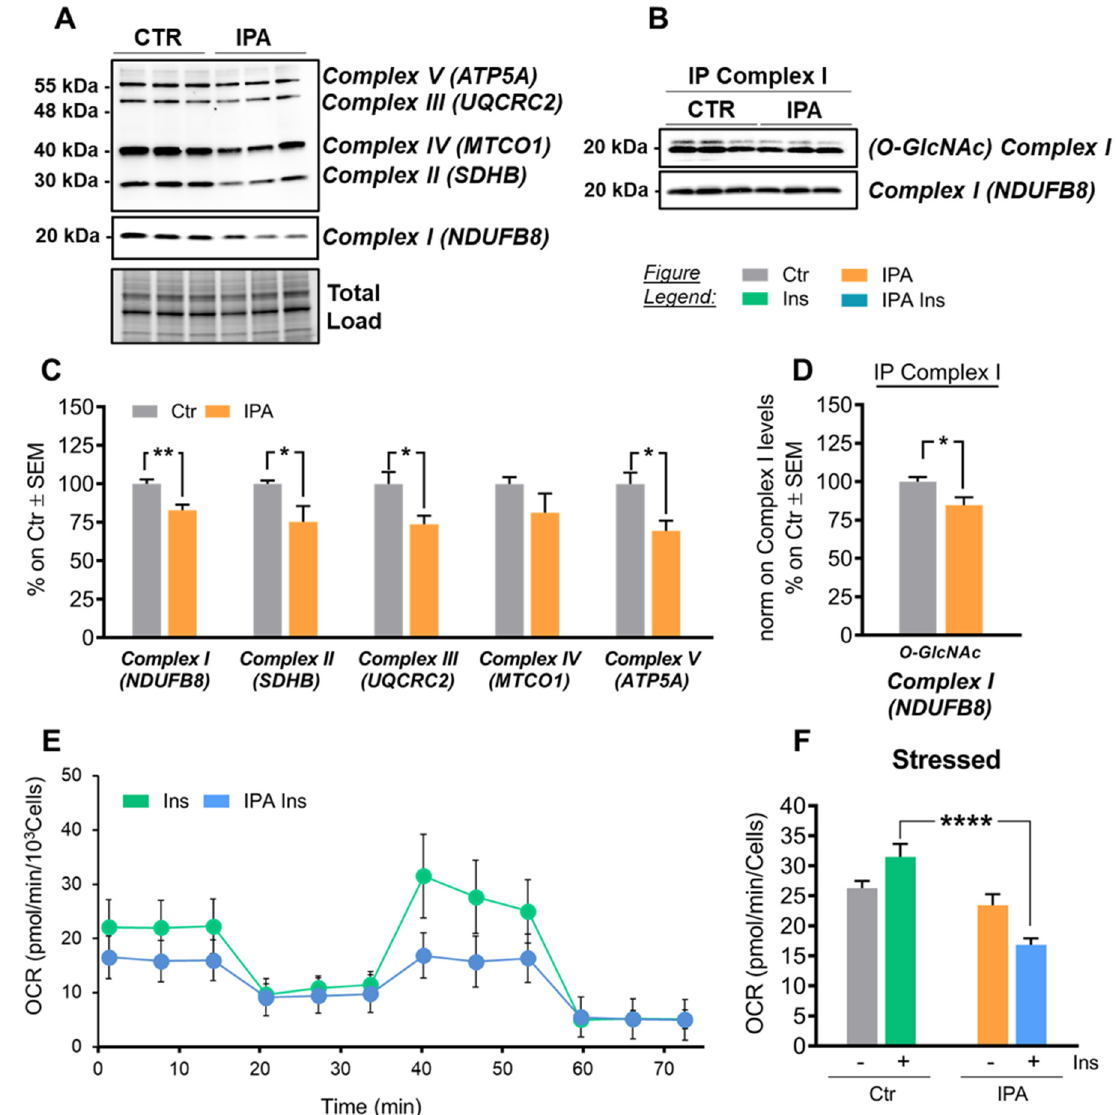
Figure 8. IPA treatment in SHSY-5Y neuroblastoma cells promotes mitochondrial dysfunction. ( A , C ) Analysis of respiratory chain complex subunit expression in IPA-treated cells compared to controls. IPA treatment induced a consistent impairment in the protein expression levels of roughly all the mitochondrial complexes: Complex I (subunit NDUFB8), Complex II (subunit SDHB), Complex III (subunit UQCRC2), and Complex V (ATP5A). A trend of reduction was also observed in Complex IV (MTCO1) protein expression levels. Representative blots are reported in ( A ). ( B , C ) Immunoprecipitation analysis of the O-GlcNAcylated levels of Complex I subunit NDUFB8 in IPA-treated cells in comparison to controls. IPA-treated cells showed a significant impairment in NDUFB8 O-GlcNAcylated levels. Representative blots are reported in ( B ). ( E , F ) Bioenergetic profile of neuroblastoma cells after insulin treatment. ( E ) The mitochondrial respiration of +/ − IPA pretreated neuroblastoma after 30 (cid:48) of insulin incubation, obtained by means of OCR by Seahorse experiments. ( F ) The stressed OCR graph comparing +/ − IPA-treated cells subjected or not to insulin incubation. In the figure, a representative experiment, values reported in the plot are the means of 16 replicates ± SD. Time course of the control samples, for both OCR and ECAR are reported in Figure S2. Number of replicates for each condition were as follow: n = 6/group for Western blot analysis and n = 16/group for Seahorse. All bar charts reported in ( C ) and ( D , F ) show mean ± SEM. Bar charts reported in ( E ) show mean ± SD. * p < 0.05, ** p < 0.01, **** p > 0.0001 using Student’s t test and 1-way